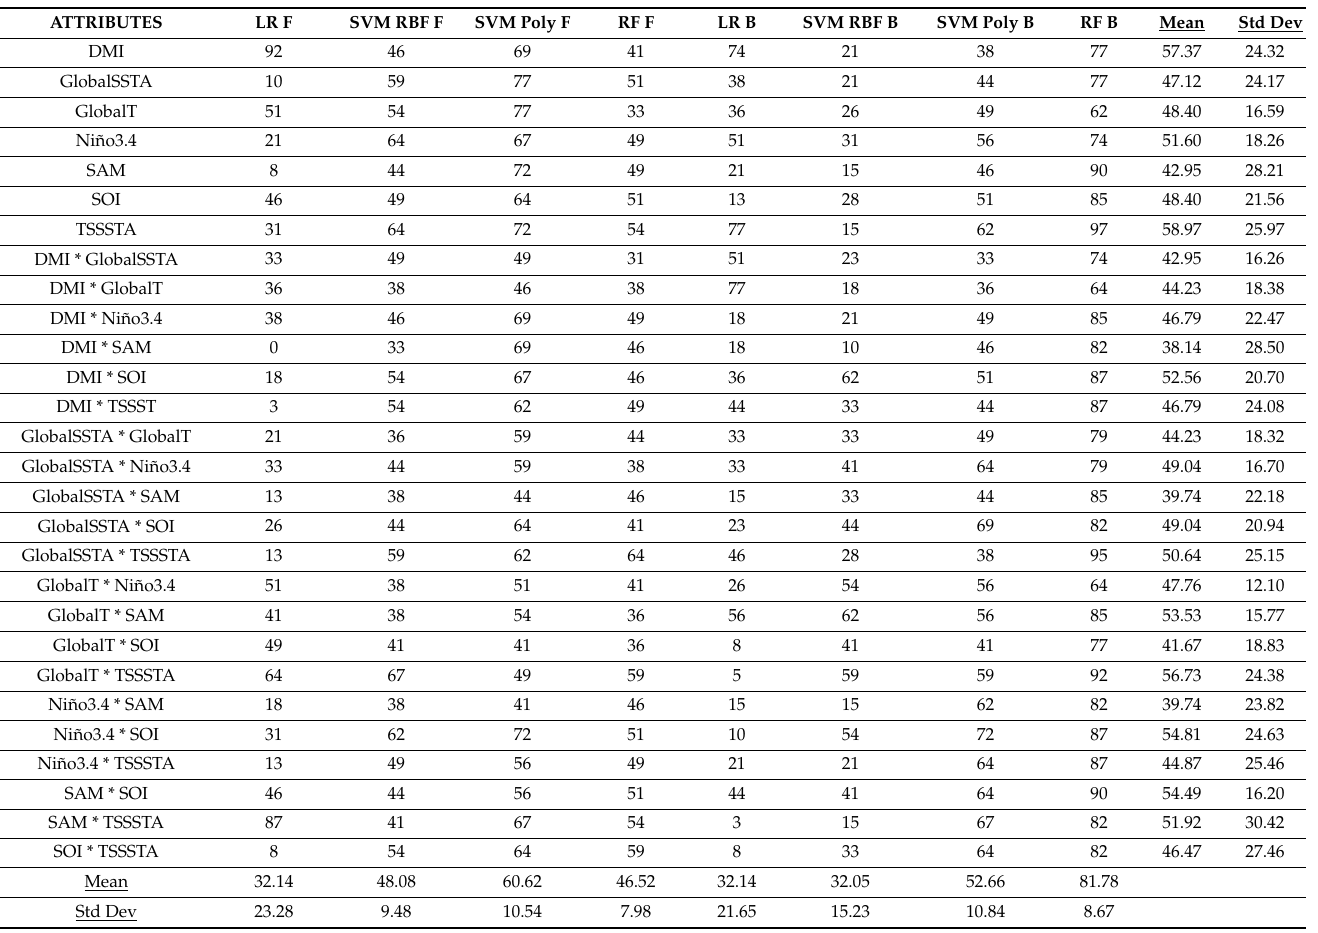
Table 5. Attribute selection for Sydney data using the eight different ML techniques. The percentage of expanding windows selecting the attribute is shown for each of the eight methods (columns 2–9). The mean and standard deviation for rows and columns is